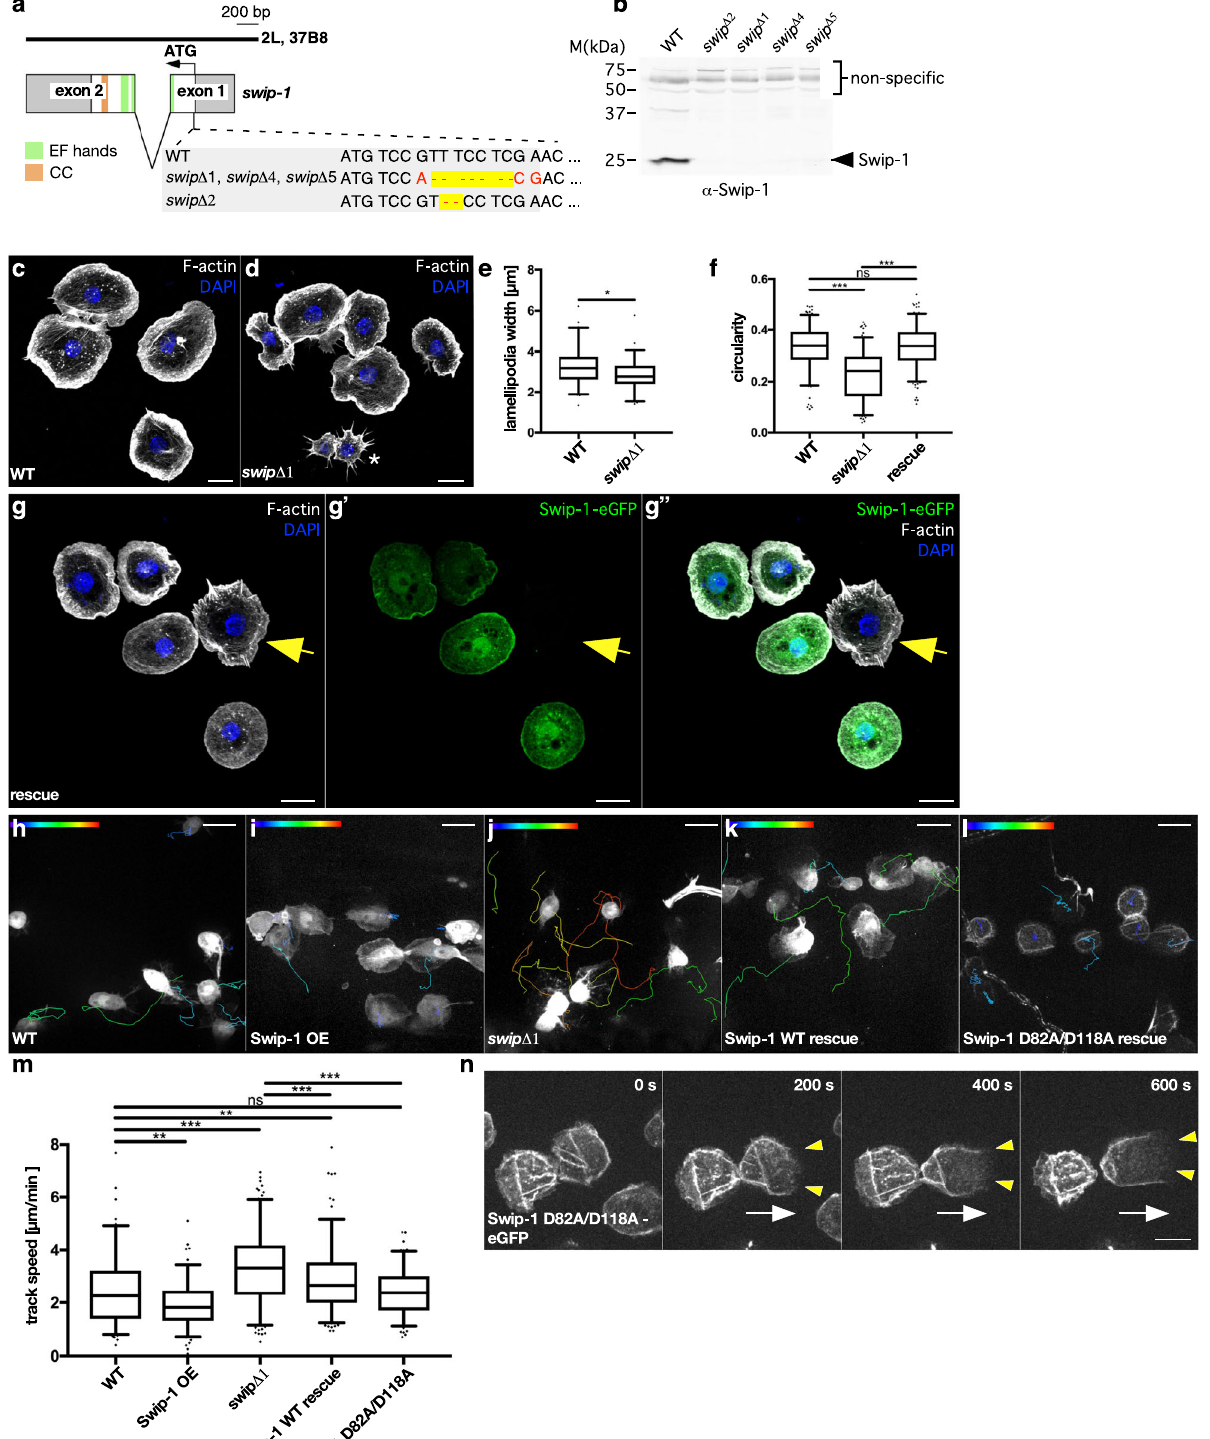
calcium-binding de fi cient Swip-1 mutant protein D82A/D118A in which the highly conserved fi rst coordinating aspartic acid of both EF-loops was replaced with an alanine. Subsequent TIRF analysis revealed that this mutant protein still induced stable, perpendicular cross-links, albeit in a calcium-independent manner (Supplementary Fig. 3 and Supplementary Movie 9). the EF-hand triggered by calcium binding have been